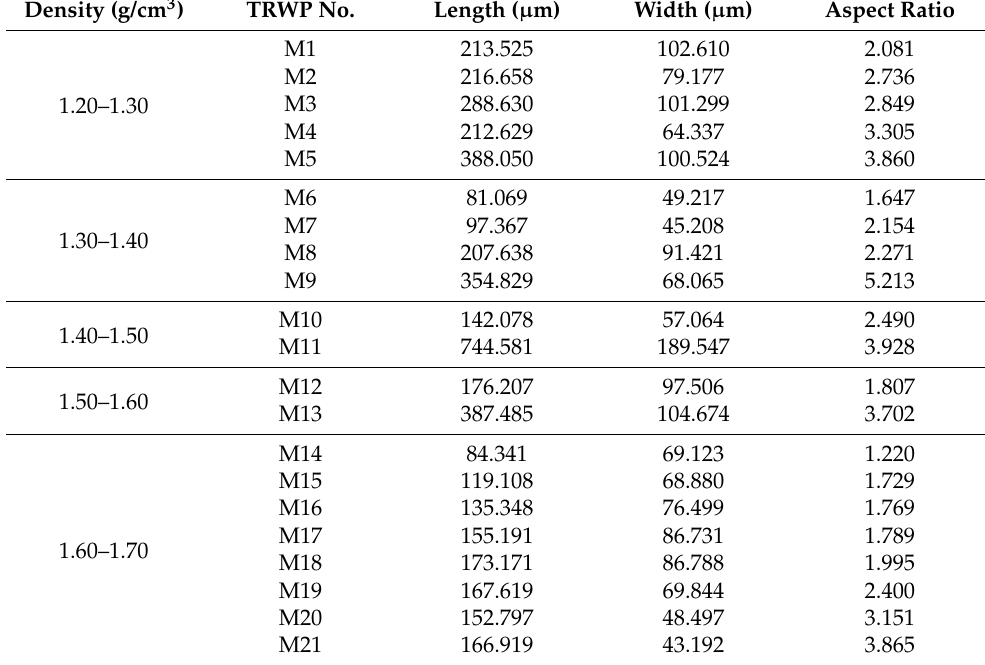
Table 3. Aspect ratios of TRWPs separated from the RD3 sample (106–212 µ m). Density (g/cm 3 ) TRWP No. Length ( µ m) Width ( µ m)